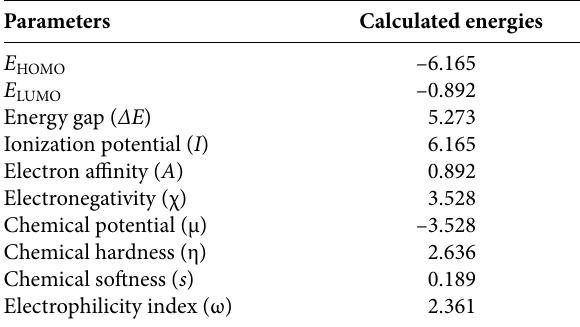
Table 8. Calculated energy values of the title compound by B3LY- P/6-311G(d,p) method.